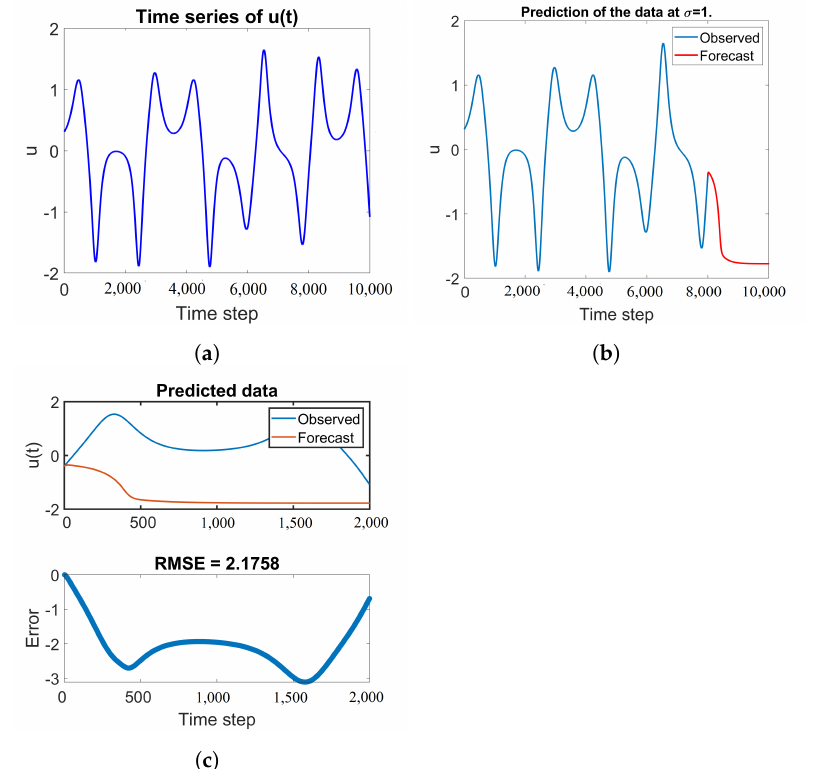
Figure 15. ( a ) The time series of u ( t ) of the model (1) obtained at σ = 1. ( b ) The prediction of time series using the LSTM method. ( c ) The predicted data and the error between observed and predicted time series.